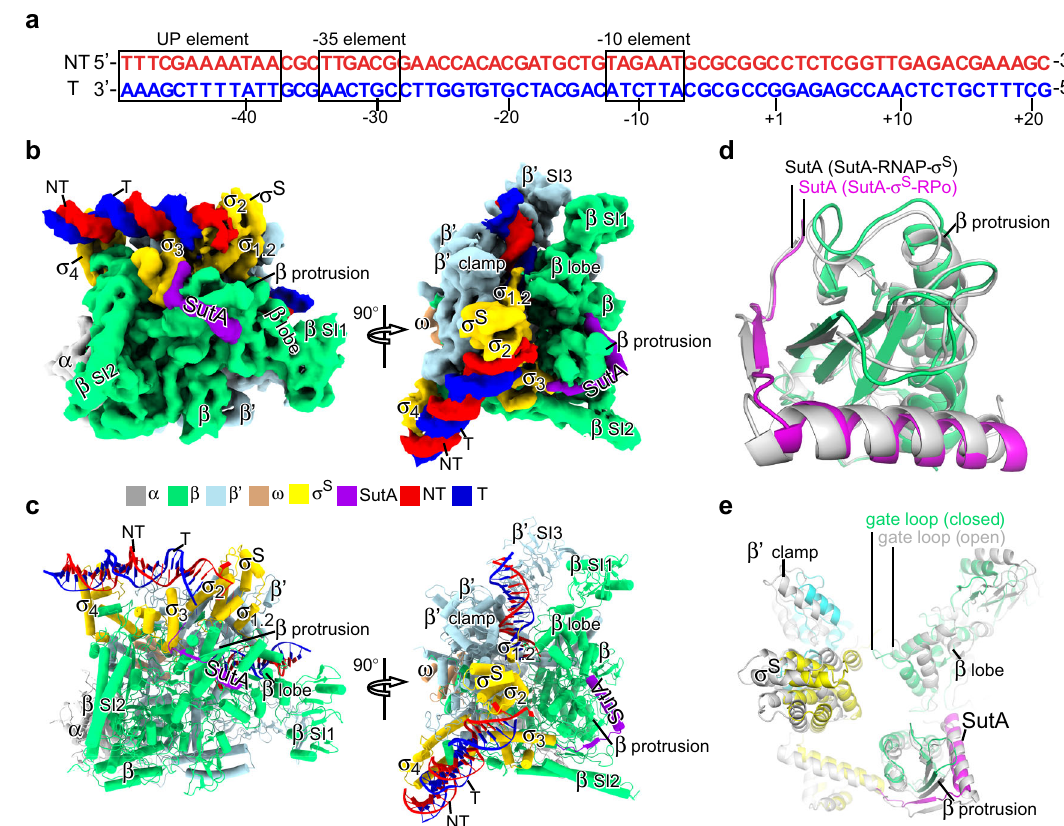
Fig. 6 The cryo-EM structure of Pae SutA- σ S -RPo. a The promoter DNA used in structure determination of Pae SutA- σ S -RPo. b The side and top view orientations of the cryo-EM map. RNAP subunits and SutA are colored as the color scheme. c The side and top view orientations of structure model of the SutA- σ S -RPo. d SutA remains attached on and makes interaction with RNAP- β protrusion in the SutA- σ S -RPo as it does in the structure of SutA-RNAP- σ S . SutA- σ S -RPo is colored as above and SutA-RNAP- σ S (open lobe) is colored in gray. e Structural superimposition of SutA-RNAP- σ S (open lobe) and SutA- σ S -RPo shows the β lobe and β ’ clamp is closed upon RPo formation. The SutA- σ S -RPo is colored as above and SutA-RNAP- σ S (open lobe) is colored in gray.